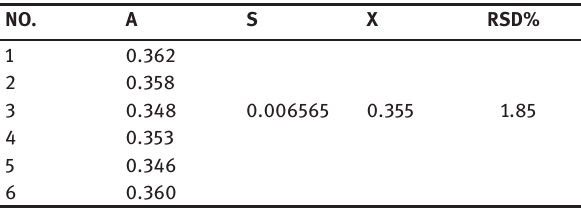
Table 3: Experimental results of repeated experimental solution.